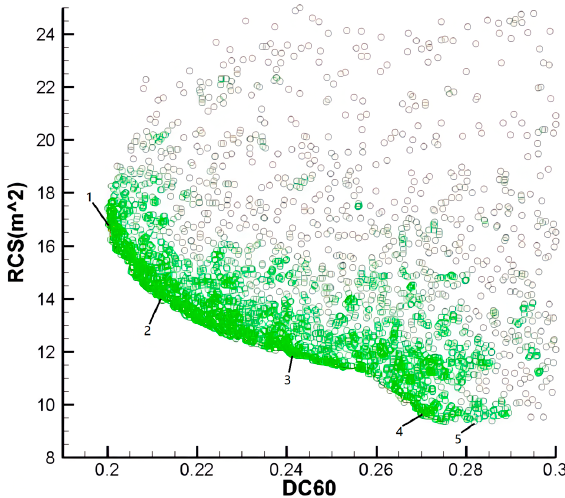
Figure 13. Pareto front of multi-objective optimization. Five sample points marked in Figure 13 were randomly selected from the Pareto front to verify the reliability of the front. Figure 14 shows the Mach number distributions. The RCS values are shown in Figure 15. The backflow zone of each intake was significantly smaller than that of the original intake and the shock wave intensity was remarkably re- duced. Besides, five intakes have smaller RCS values than the original intake. Ma Model 1 Model 2 Model 3